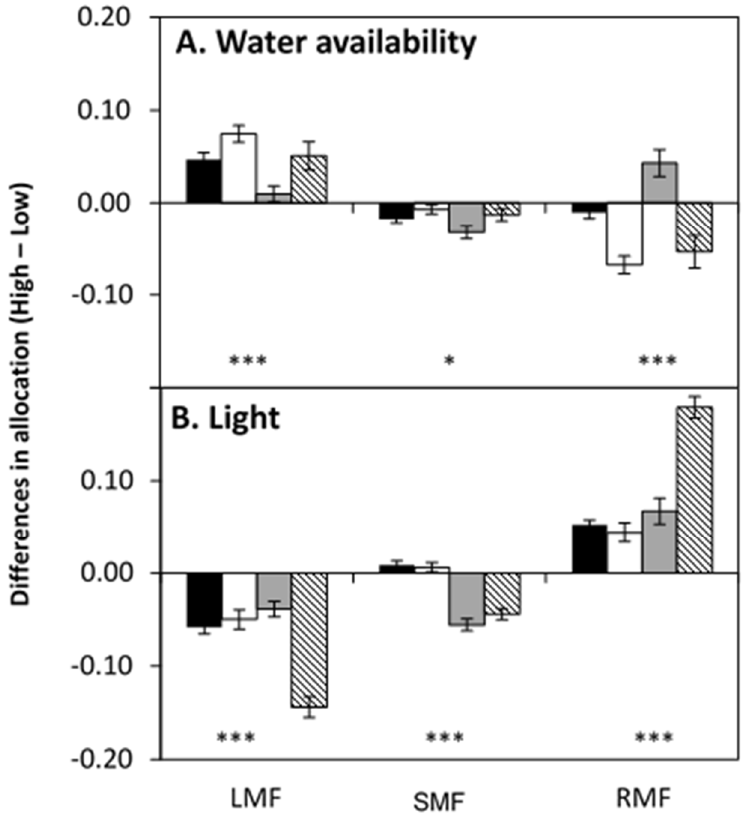
Figure 4. Differences in biomass allocation between plants grown at a high (W+ or L+) and a low level (W − or L − of resource availability. Average values ( ± SE). ( A ) Water availability, ( B ) Light. Asterisks at the bottom of the panels indicate the significance level under the H0 hypothesis of no difference in allocation between species (* p < 0.05, ** p < 0.01, *** p < 0.001). LMF, leaf mass fraction; SMF, stem mass fraction; RMF, root mass fraction. Pinus pinea (black), Juniperus thurifera (white), Quercus faginea (grey), Quercus ilex (dashed line).